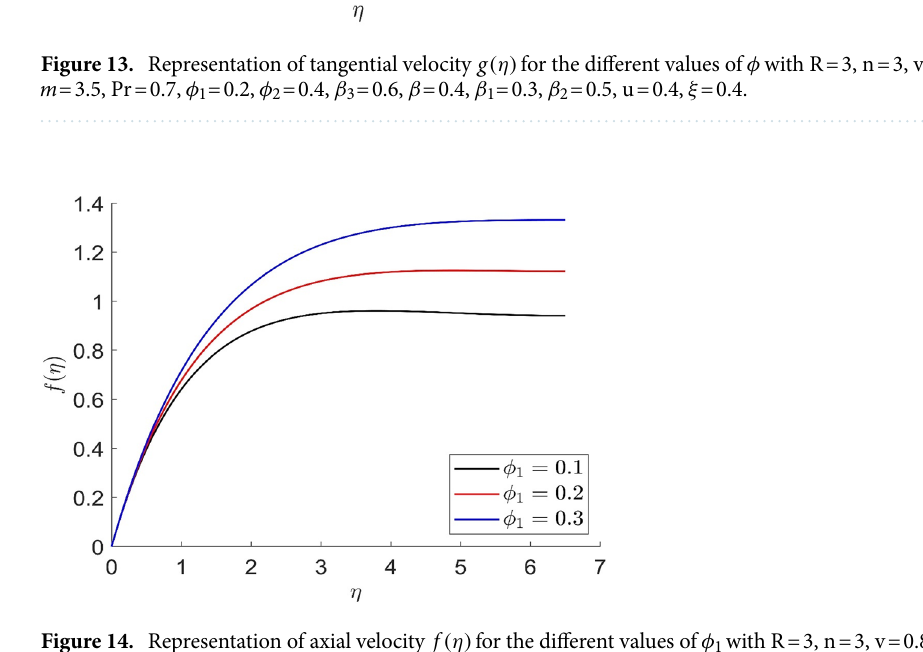
Figure 14. Representation of axial velocity f (η) for the different values of φ 1 with R = 3, n = 3, v = 0.8, m = 3.5, Pr = 0.9, φ = 0.1, φ 2 = 0.7, β 3 = 0.6, β = 0.3, β 1 = 0.5, β 2 = 0.8, u = 0.5, ξ =